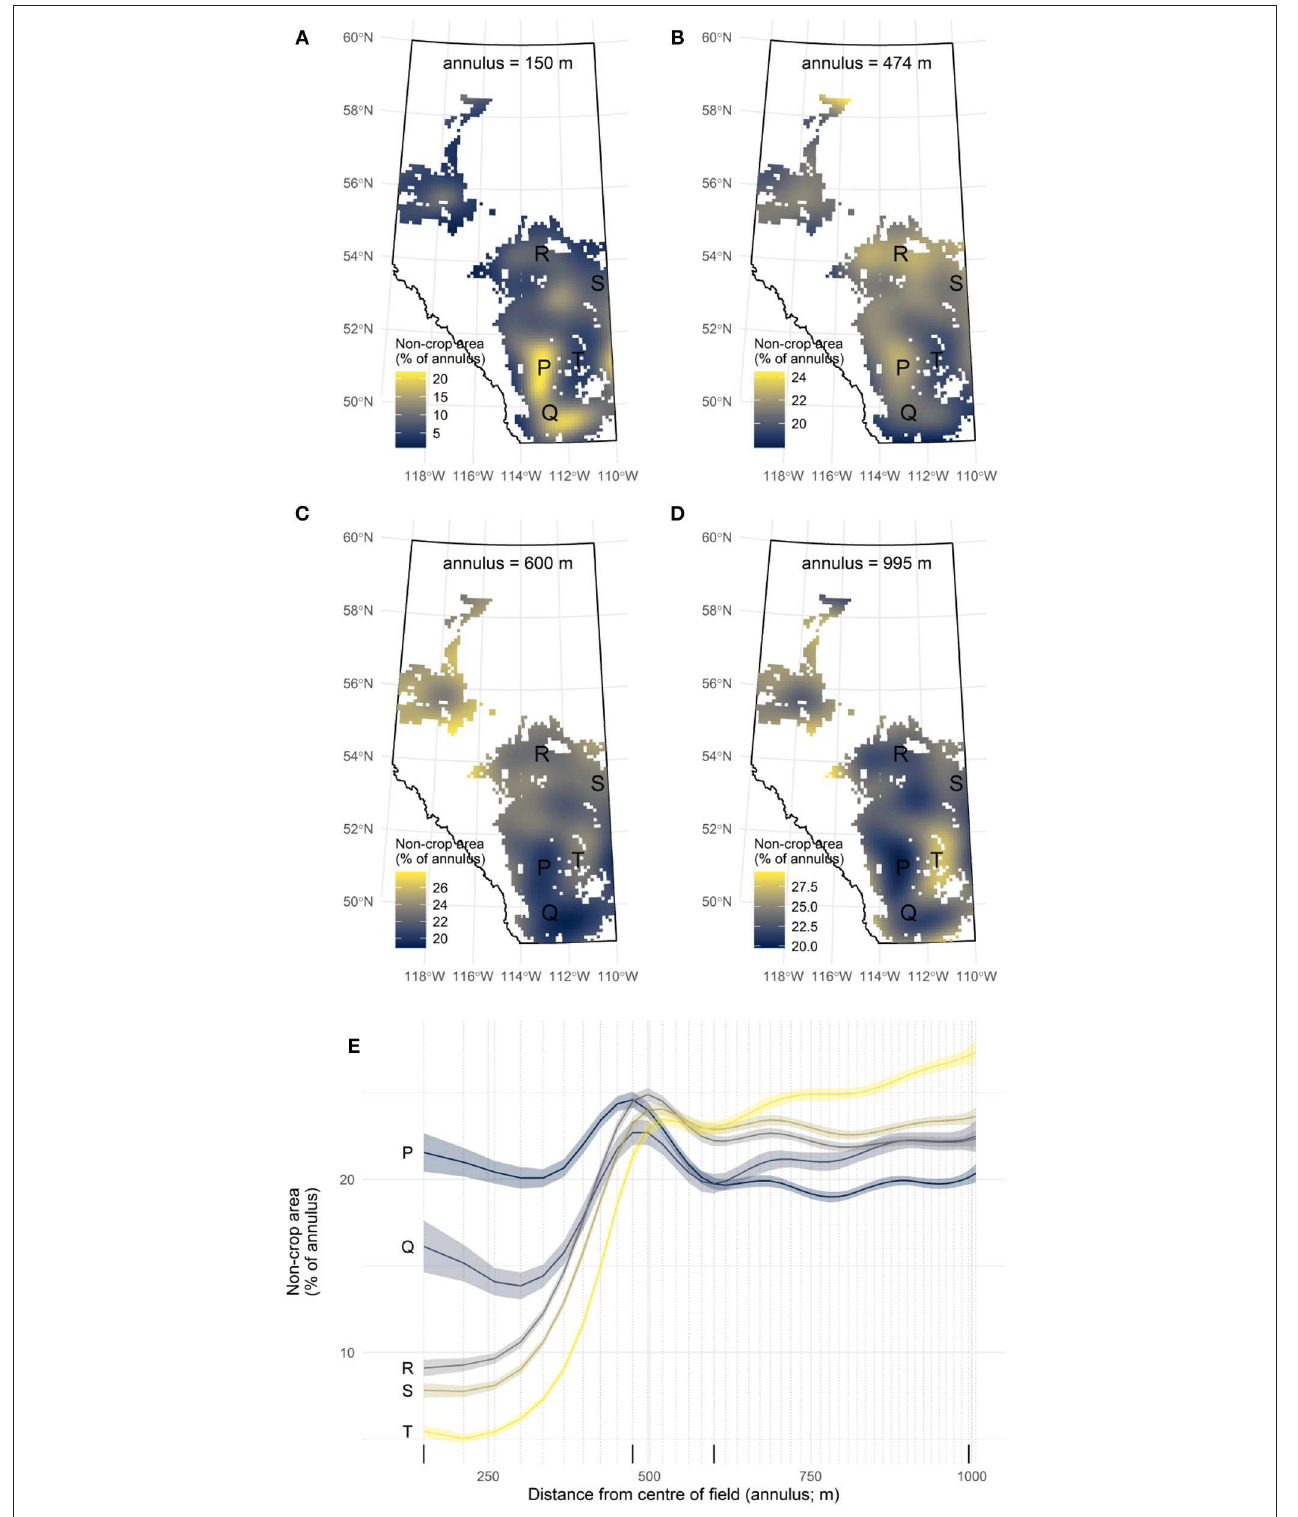
FIGURE 4 | Predictions from the model while controlling for all covariates except the spatial term. Non-crop area is shown at four different annuli to demonstrate: (A) the field scale; (B) the field margin scale; (C,D) the neighborhood scale. (E) Landscape complexity curves at four locations ( P, Q, R, S, and T ) represent predictions across all scales and are intended to illustrate how the entire curve varies over the study region.